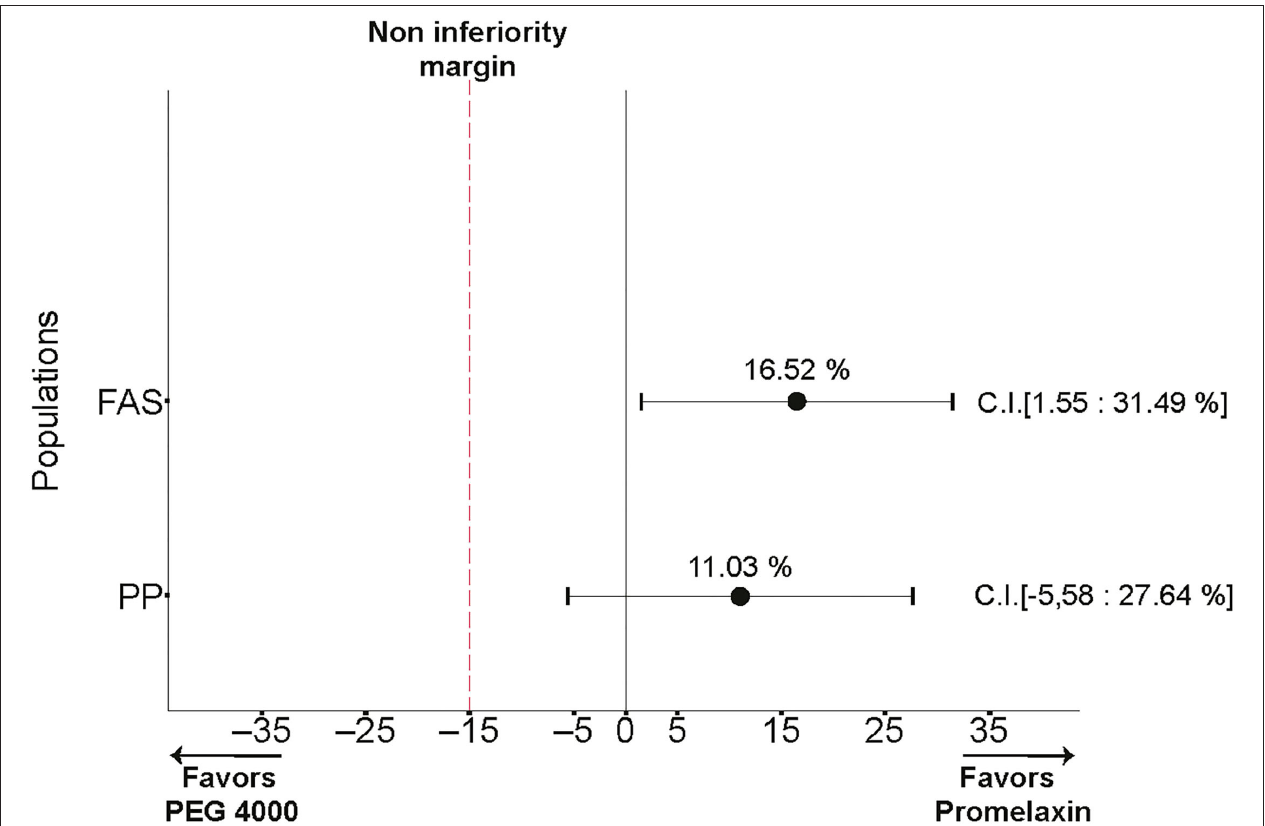
FIGURE 3 | Primary endpoint. The differences in response rates between Promelaxin and PEG and relative 95% confidence interval (CI) are shown according to the full analysis set (FAS) and the PP analyses.